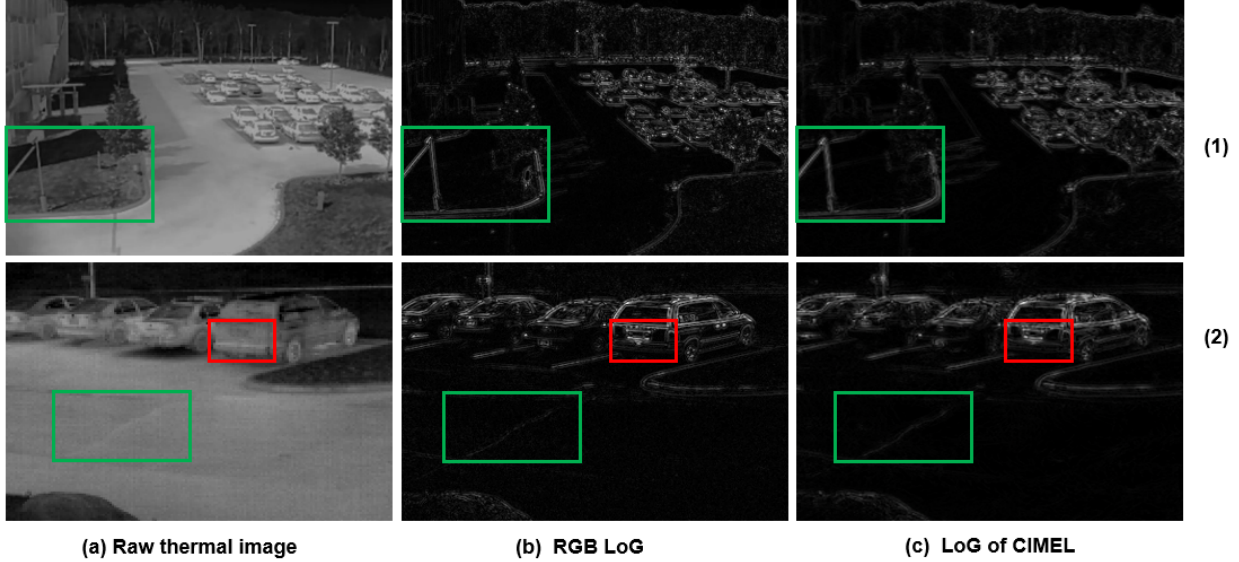
Figure 7. Two types of edges from the LoG algorithm: Edges weak in the IR spectrum but strong in the corresponding visual image (red rectangle); Edges which are strong in both IR and visual images (green